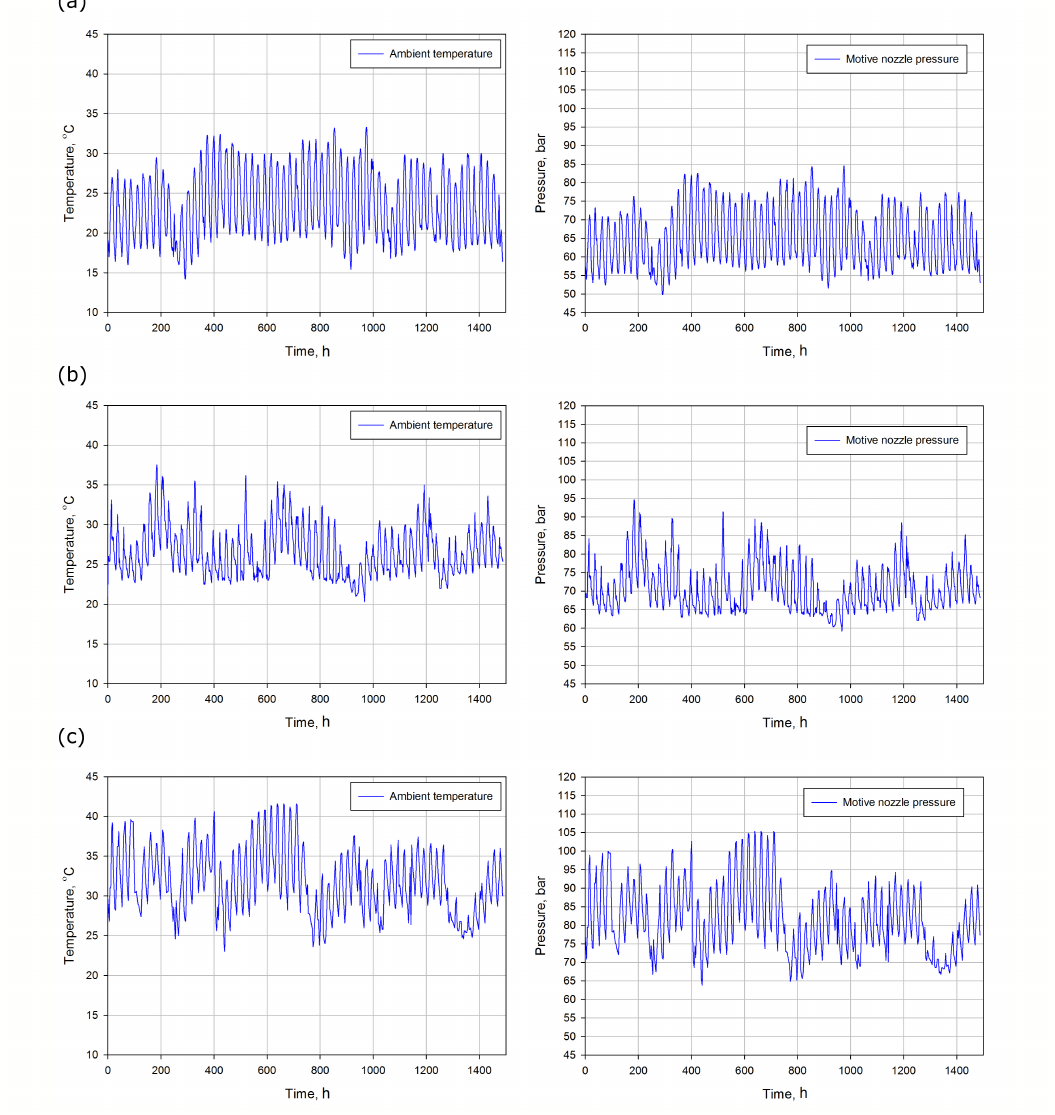
Figure 8. The relationship between the ambient conditions ( left ) and the gas cooler outlet pressure/motive nozzle pressure ( right ) during the summer campaign in different regions: ( a ) Mediterranean zone; ( b ) South America zone; ( c ) South Asia